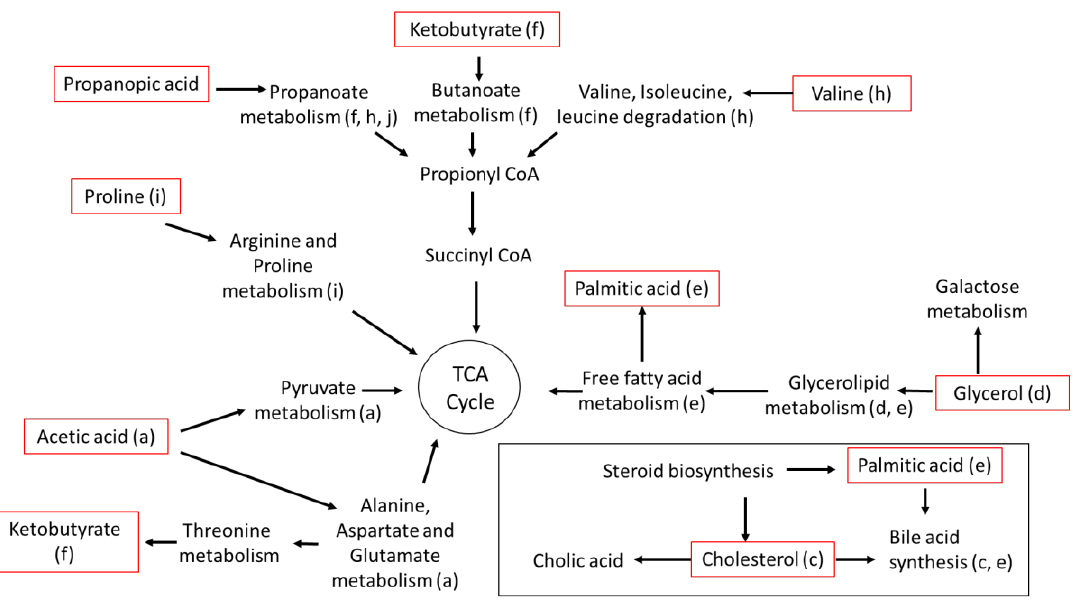
Figure 8. Metabolic pathways affected by PFAS exposure following a 7-day exposure. Red outline indicates the metabolites that changed significantly in abundance (listed in Tables 2 – 4).